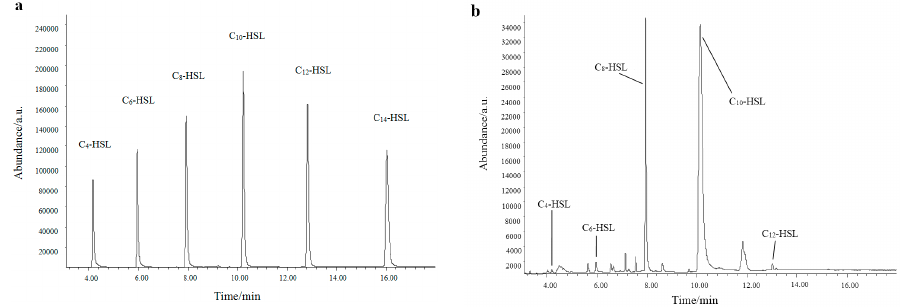
Figure 4. GC-MS chromatogram in SIM mode at m/z 143 of a standard mixture of AHLs ( a ) and an extract of cell-free supernatant of AS7 ( b ).